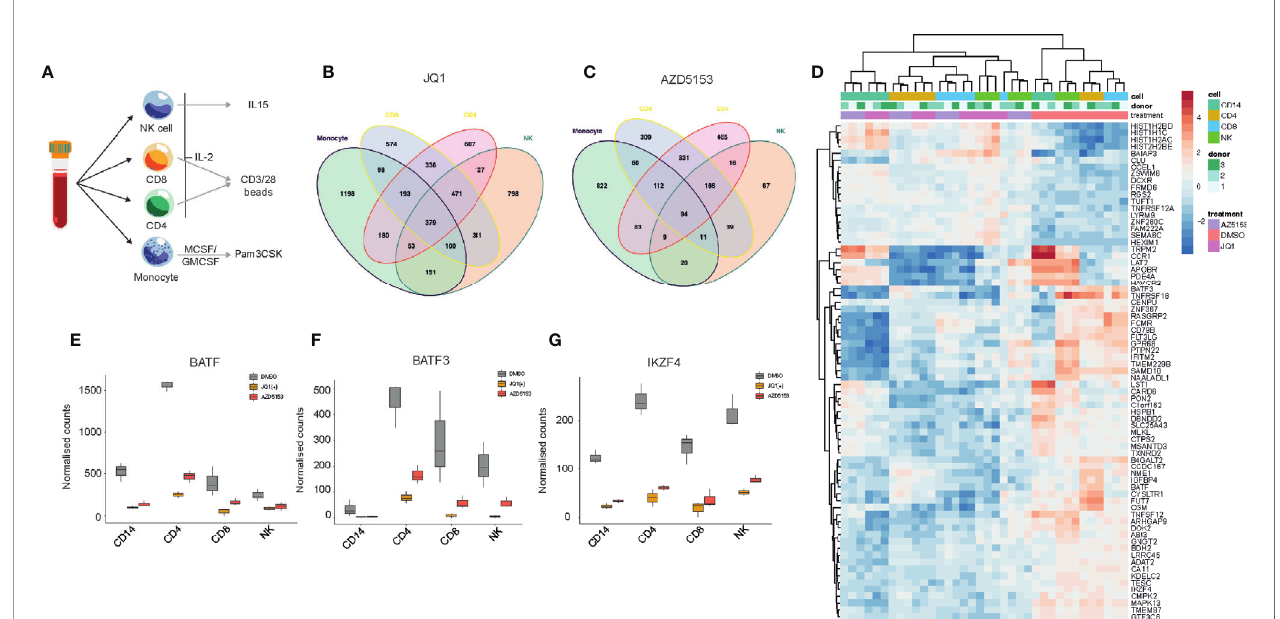
FIGURE 5 | BET bromodomain inhibitors have a broad anti-in fl ammatory effect on the immune system. (A) A schematic showing the experimental setup. NK, CD8, CD4 and monocytes were isolated from healthy peripheral blood and then cultured in the presence of cytokines for 24 h before being stimulated with either IL-15 (10 ng/ml), CD3/28 activation beads (1:1 ratio) or MCSF/GMCSF (10 ng/ml). (B) A Venn diagram showing the overlapping differentially regulated genes for NK, CD4, CD8 and monocytes following 24 h of JQ1(+) treatment. (C) A Venn diagram showing the overlapping differentially regulated genes for each NK, CD4, CD8 and monocytes following 24 h of AZD5153 treatment. (D) A heatmap showing the common genes regulated between JQ1(+) and AZD5153 across all in fl ammatory cells. (E – G) Box plots showing the normalized counts of BATF, BATF3 and IKZF4 transcription factors in NK, CD4, CD8 and monocytes following JQ1(+) or